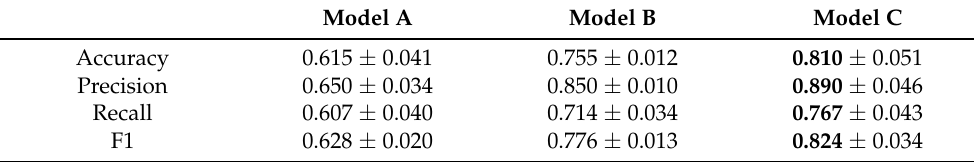
Table 5. Performance of three architectures tested on real-world images not included in the lab training set. Reported values are the average and standard deviation over the five replicas. The best performer in each row is shown in